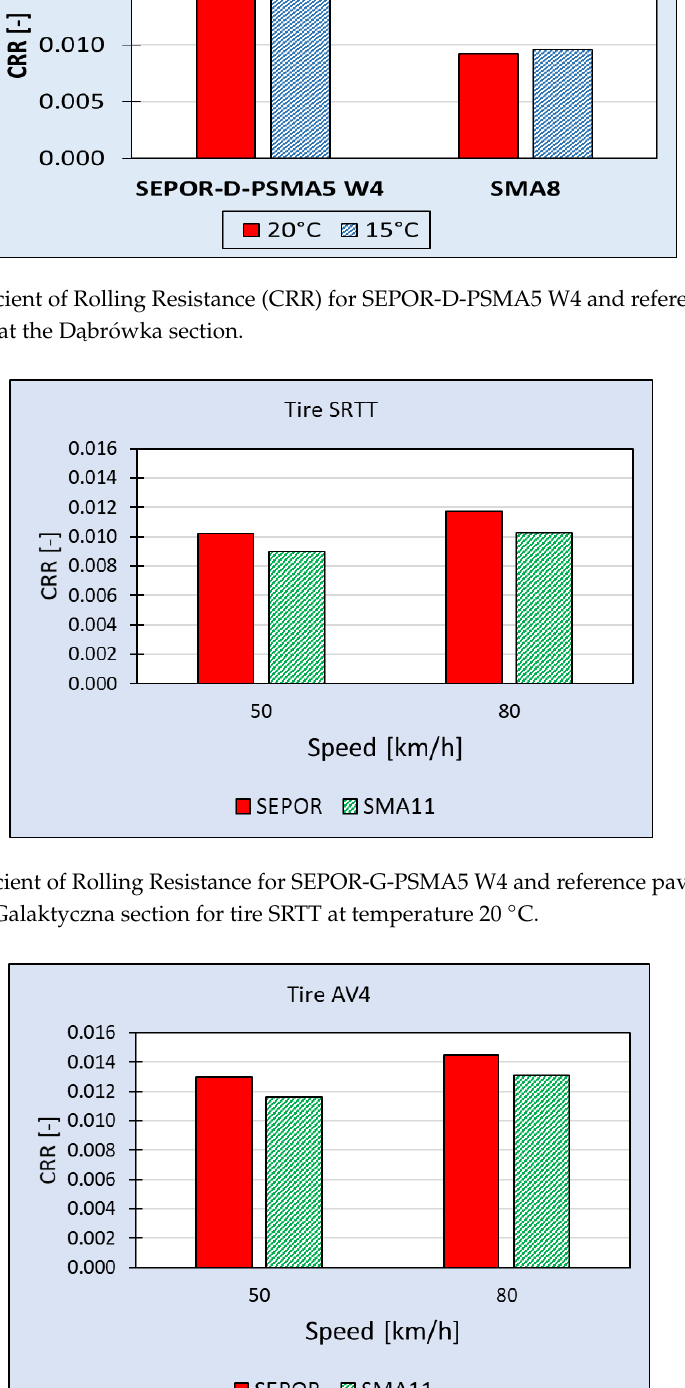
Figure 30. Coefficient of Rolling Resistance for SEPOR-G-PSMA5 W4 and reference pavement SMA11 measured at the Galaktyczna section for tire Avon AV4 at temperature 20 °C.